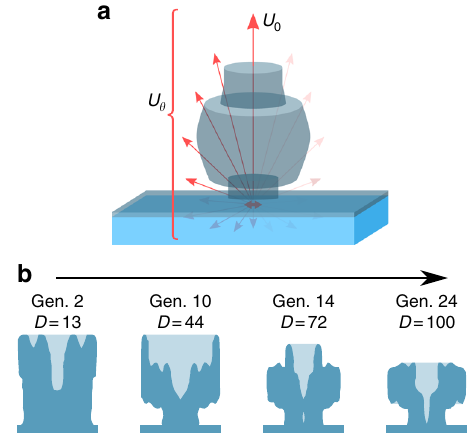
Fig. 1 Diagram of directivity and optimization. a Schematic depicting the emission (arrows) from a point emitter and nanolens, with U 0 representing the emission in the θ = 0 direction, and U θ being the total emission in all angles. b Series of snapshots in an example optimization process, showing the revolved cross-sections (dark blue, with background material in light blue) of lens structures as the optimization progresses, accompanied by higher achieved directivity values,